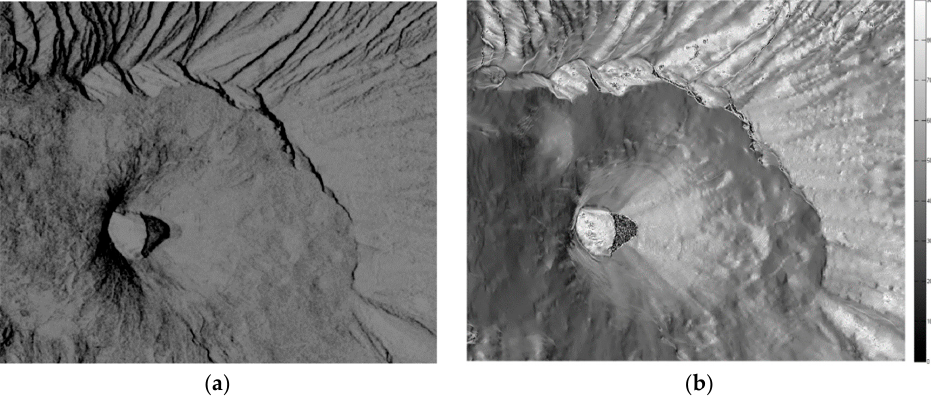
Figure 19. Local incidence angle map (in degree): ( a ) estimated from spatial multilook SAR image; ( b ) ground truth. Grayscale is in the range 0°–90°.